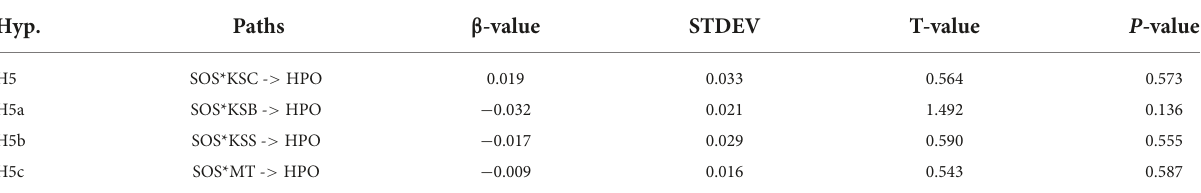
TABLE 7 Structural equation model results for moderation.